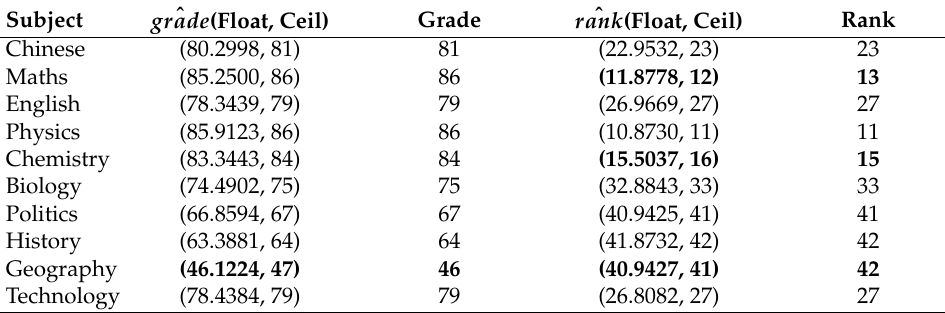
Figure 10. The curve of loss function in extended data. Table 5. Prediction Performance of Proposed